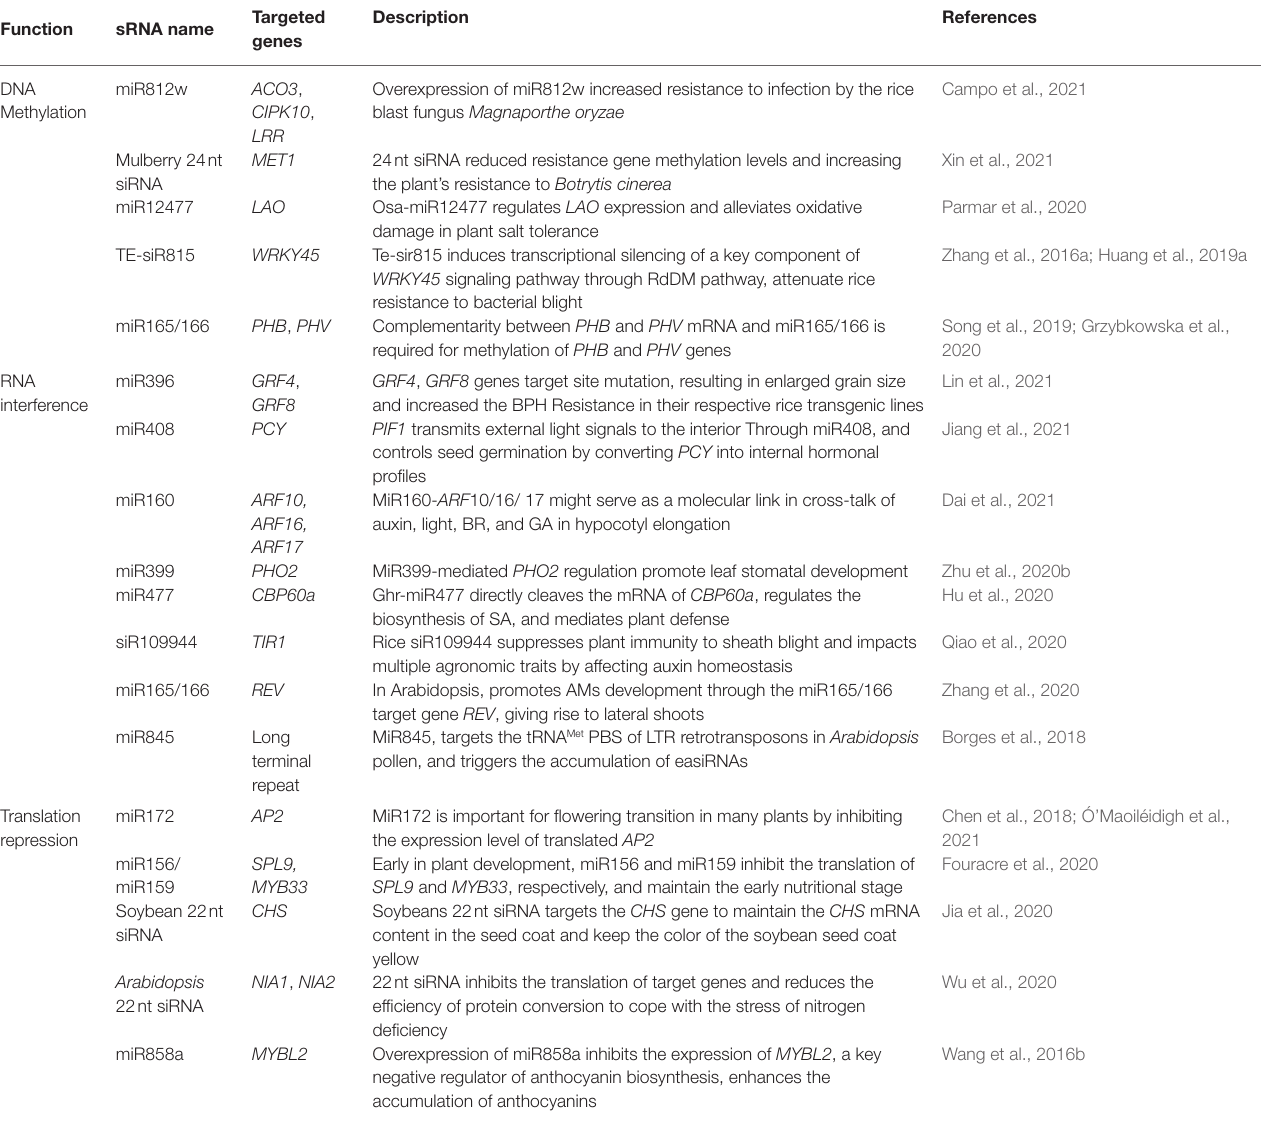
ACO3: 1-AMINOCYCLOPROPANE-1-CARBOXYLIC ACID OXIDASE; CIPK10: CBL-INTERACTING PROTEIN KINASE10; LRR: LEUCINE-RICH REPEAT; MET1: MAKES METHIONINE 1; LOA: L-ASCORBATE OXIDASE; WRKY45: PHB: PHABULOSA; PHV: PHAVOLUTA; GRF: GROWTH REGULATING FACTOR; BPH: brown planthopper; PIF1: PHYTOCHROME INTERACTING FACTOR 1; PCY: PLANTACYANIN; ARF: AUXIN RESPONSE FACTOR; BR: brassinosteroid; GA: gibberellin; PHO2: PHOSPHATE2; CBP60a: Calmodulin-Binding Protein 60a; SA: salicylates; TIR1: TRANSPORT INHIBITOR RESPONSE 1; REV: REVOLUTA; AMs: Axillary meristems; PBS: primer-binding site; LTR: long terminal repeat; AP2: APETALA2; SPL9: SQUAMOSA PROMOTER BINDING PROTEIN-LIKE9; MYB33: MYB DOMAIN PROTEIN33; GHS: CHALCONE SYNTHASE; NIA: NITRATE REDUCTASE; MYBL2: MYB PROTO-ONCOGENE LIKE